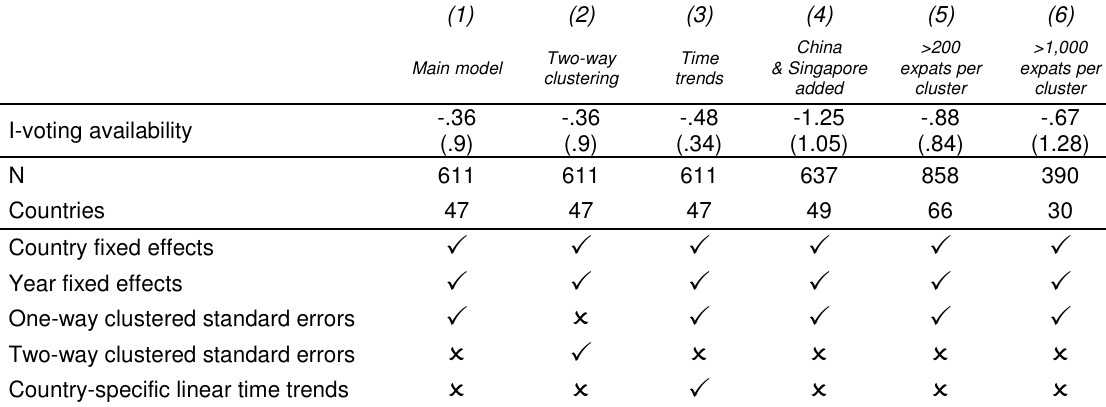
Table 4: Difference-in-differences